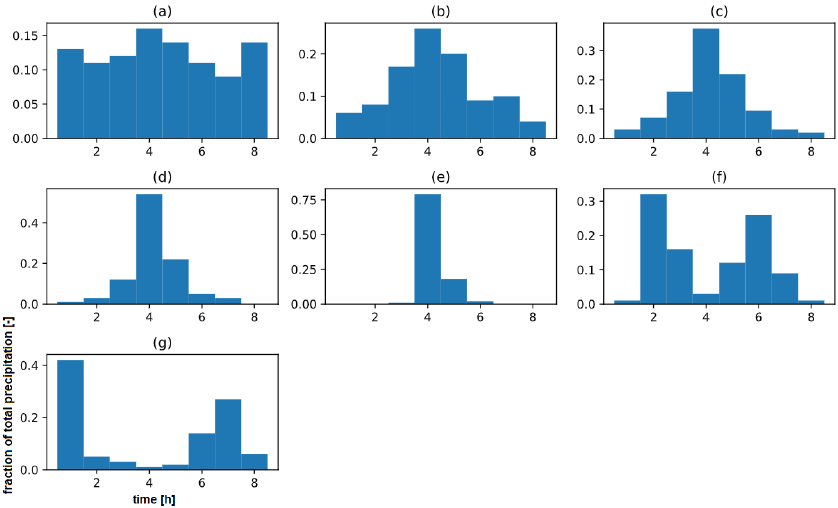
Figure 5. Seven precipitation patterns for a duration of 8 h, with ( a ) Uniform; ( b ) 1 peak—12.5%; ( c ) 1 peak—37.5%; ( d ) 1 peak—62.5%; ( e ) 1 peak—87.5%; ( f ) 2 peaks—short; and ( g ) 2 peaks—long. Table 1. All possible values for each precipitation event feature. P intensities P